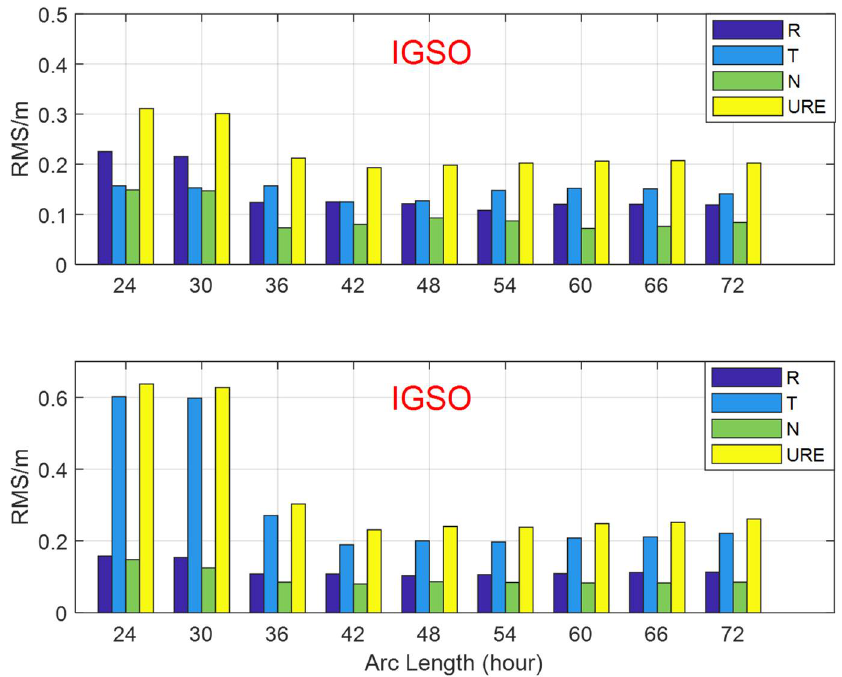
Figure 1. The accuracy of the first 6 h ( top ) and 24 h ( bottom ) of predicted BDS-3 MEO orbits with different arc lengths.